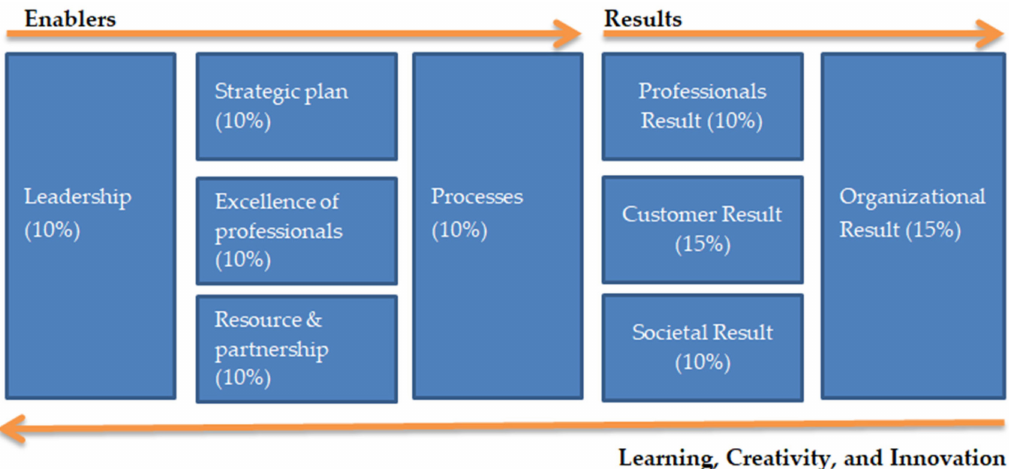
Figure 1. EFQM excellence model (Source: adapted from EFQM